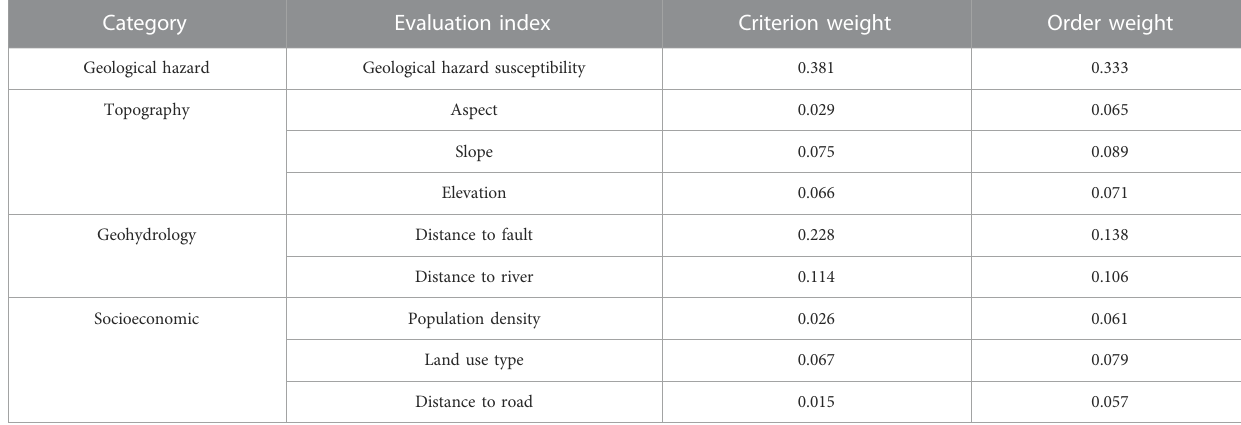
TABLE 5 Weights of suitability evaluation